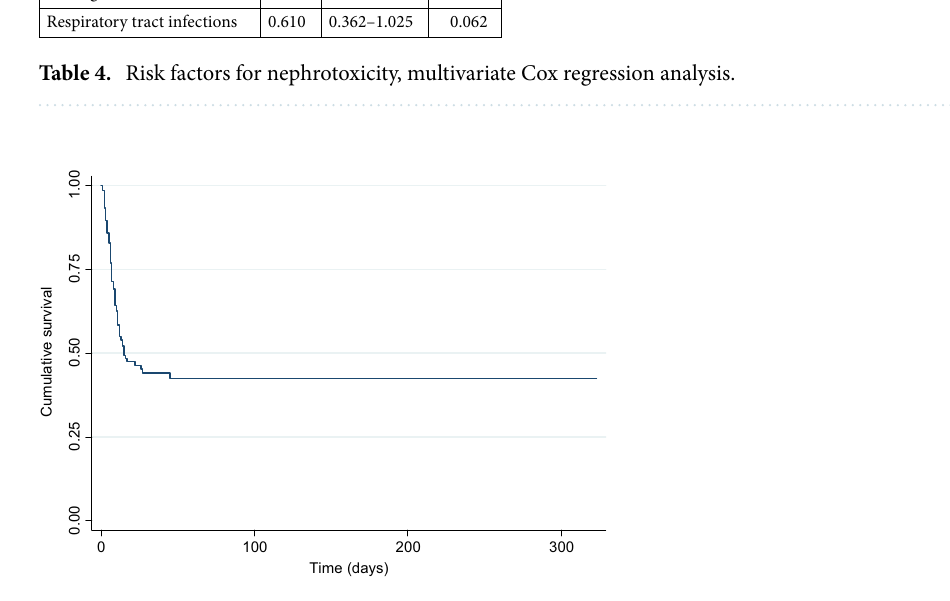
Figure 1. Kaplan–Meier survival curve of patients with incidence of